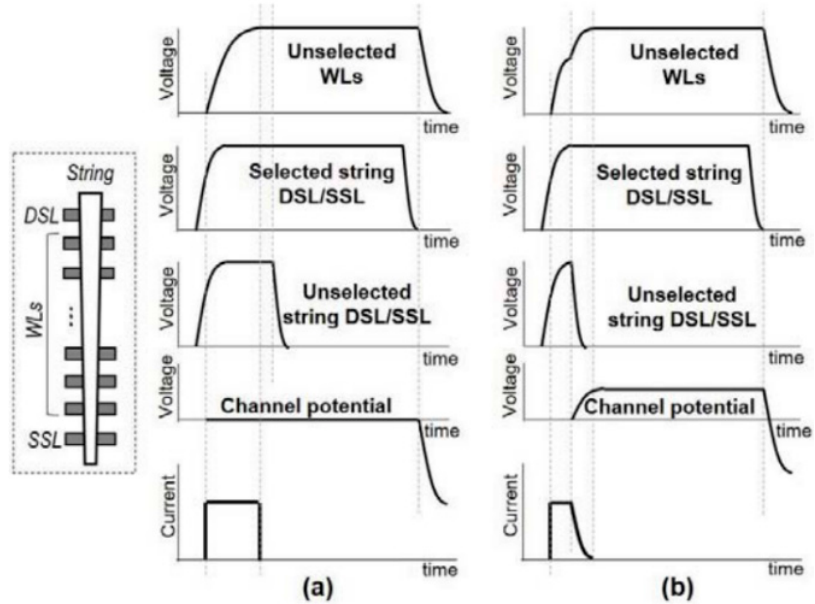
Figure 8. Read operation ( a ) with a conventional channel initialization. Reprinted/adapted with permission from Ref. [63], 2022, IEEE. ( b ) with the proposed unselected string boosting scheme. Reprinted/adapted with permission from Ref. [63], 2022, IEEE.